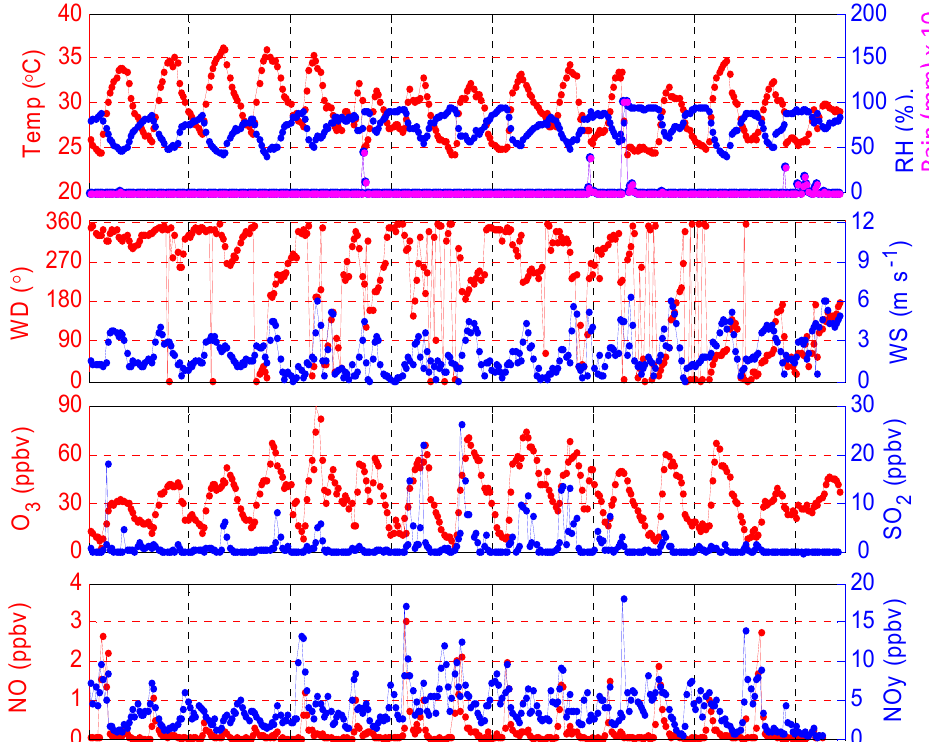
Figure 2. Measurements of meteorological parameters, trace chemical pollutants, and mercury species during the Grand Bay Intensive in summer